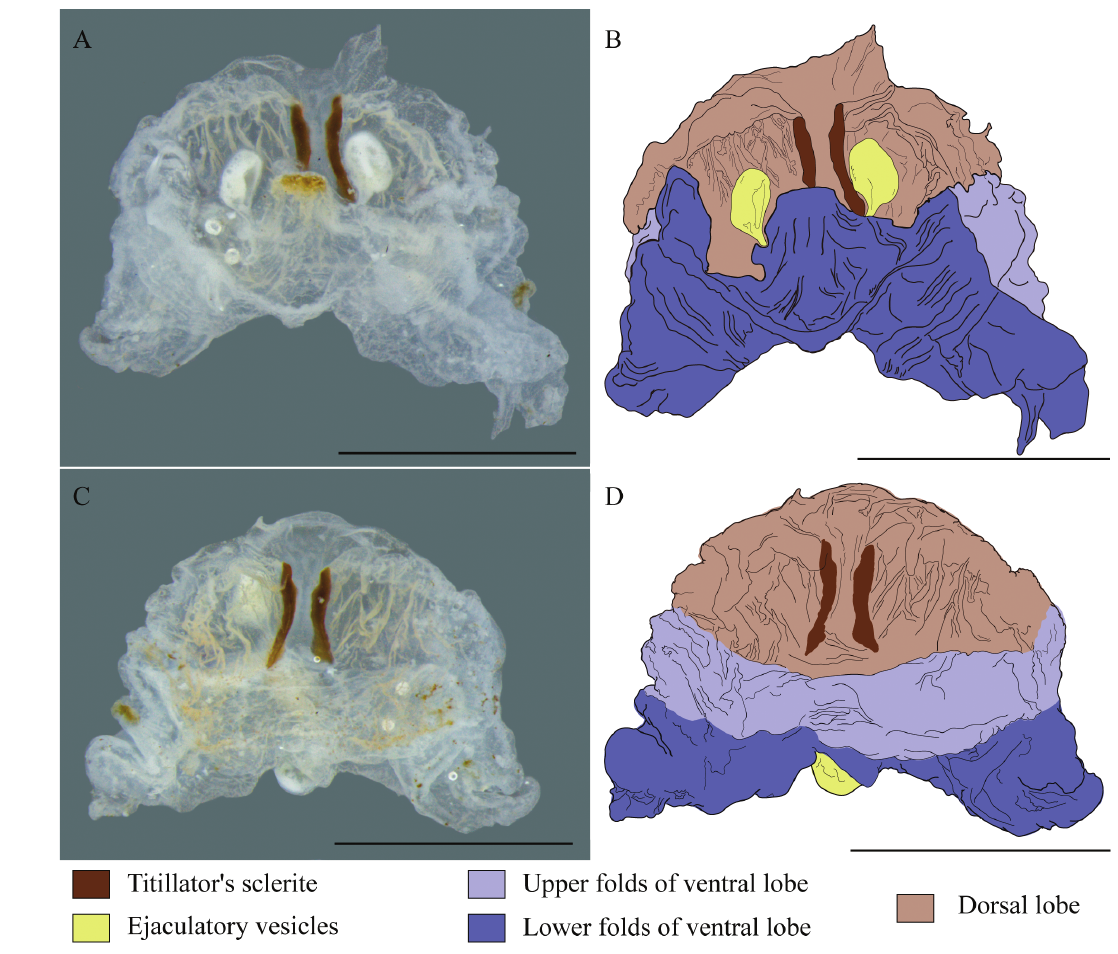
Fig. 4. Male genitalia of Toledopizia salesopolensis . A, B. Anterior view; C, D. Posterior view.